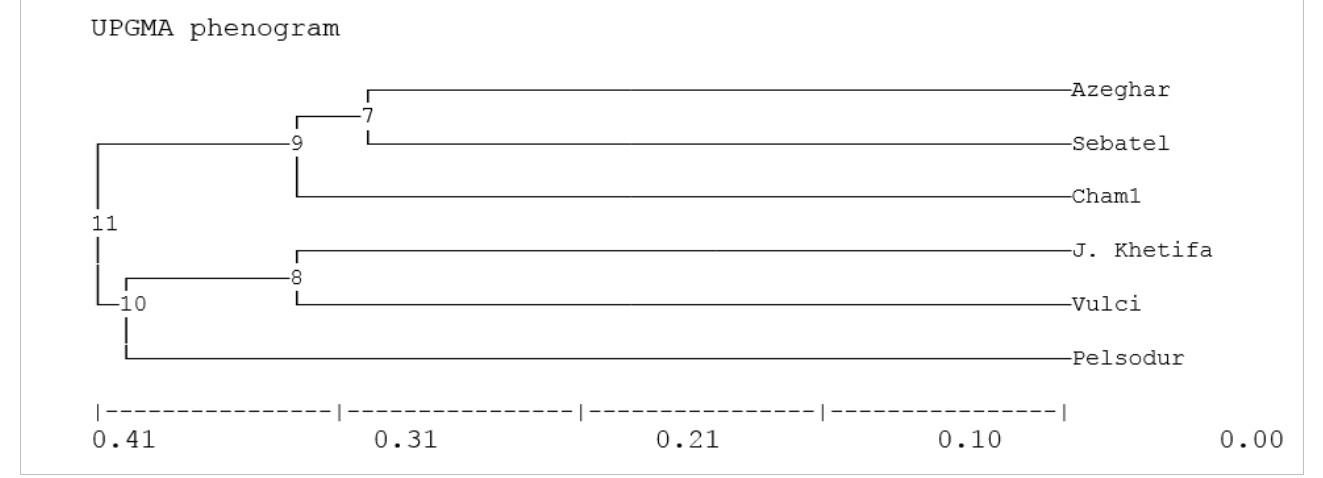
Figure 4. UPGMA phenogram of the Nei genetic distance among six durum wheat genotypes based on 11 SSRs markers.